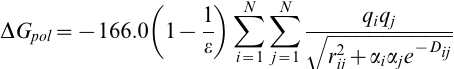
a Bold entries indicate representative protein chains. b Experiment resolution of crystal structure for representative protein chains.